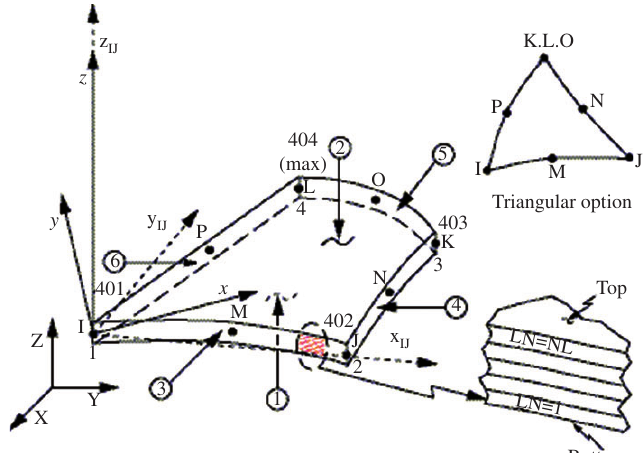
Figure 5 SHELL91 geometry [17]